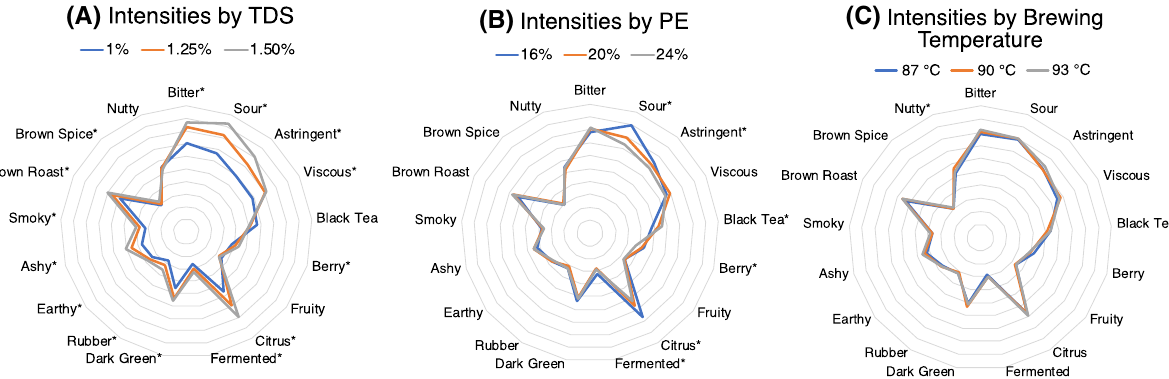
Figure 4. Spider web plots visualizing differences in attribute intensities by all variables significant for at least one of the three factors, for ( A ) TDS, ( B ) PE, and ( C ) brew temperature. Asterisks indicate statistical significance (p < 0.05). Inner ring corresponds to attribute intensity of 0, while the outer ring corresponds to an attribute intensity of 50; intermediate rings are spaced evenly in increments of 5 intensity points.